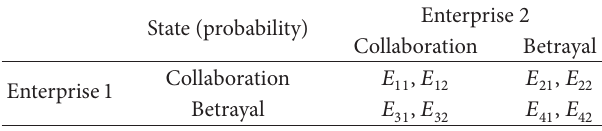
Table 1: The payoff matrix of cooperative